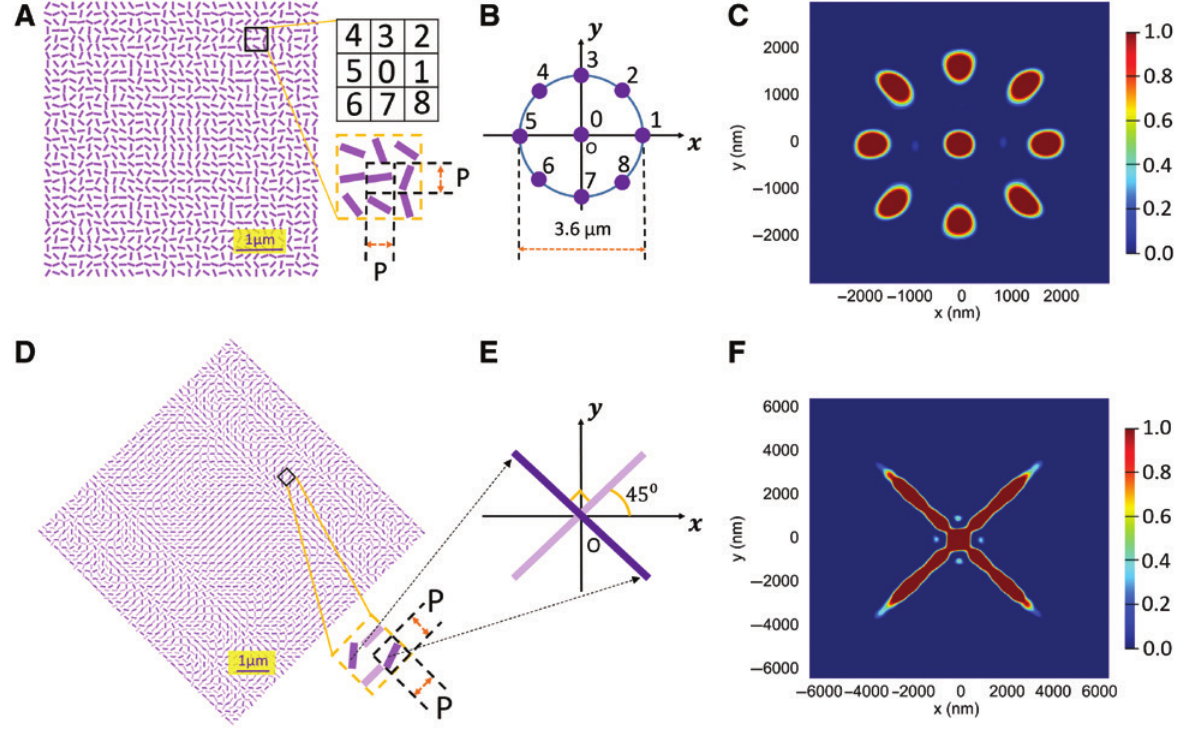
Figure 6: Light routers for mono-wavelength at UV-375 nm. (A) Top view of light router-LR1, with unit cells consisting of nine AlN nanorods, denoted as UA. The unit cell has a fixed period of 3P = 0.54 μ m. The nine nanorods in different positions are marked from 0 to 8. (B) Routing positions of metalens-LR1 in x - y coordinates. The center of the circle is located at the origin O, with the diameter of 3.6 μ m. The figures correspond to the using nanorods as shown in (A). (C) Normalized RCP light intensity distribution of the x - y section at z = 10 μ m. (D) Top view of light router-LR2, with unit cells consisting of four AlN nanorods of structure UA. The unit cell has a fixed period of 2P = 0.36 μ m. The nanorods used for different lines are marked as deep purple and light purple. (E) Routing angles of the lines of LR2 in x - y coordinates. The center of the lines is located at the origin O, with the length of 9 μ m. Colors of two lines correspond to the using nanorods, as shown in (D). The two lines form an angle of 90 ° with one of them forming an angle of 45 ° with the x -axis. (F) Normalized RCP light intensity distribution of the x - y section at z = 10 μ m. The two-dimensional arrays of LR1 and LR2 have the sizes of 5.94 μ m × 5.94 μ m and 9 μ m × 9 μ m, respectively, which means that there are 11 × 11 and 25 × 25 AlN unit cells in total for LR1 and LR2, respectively. The top surface of LR1 and LR2 is located at z =